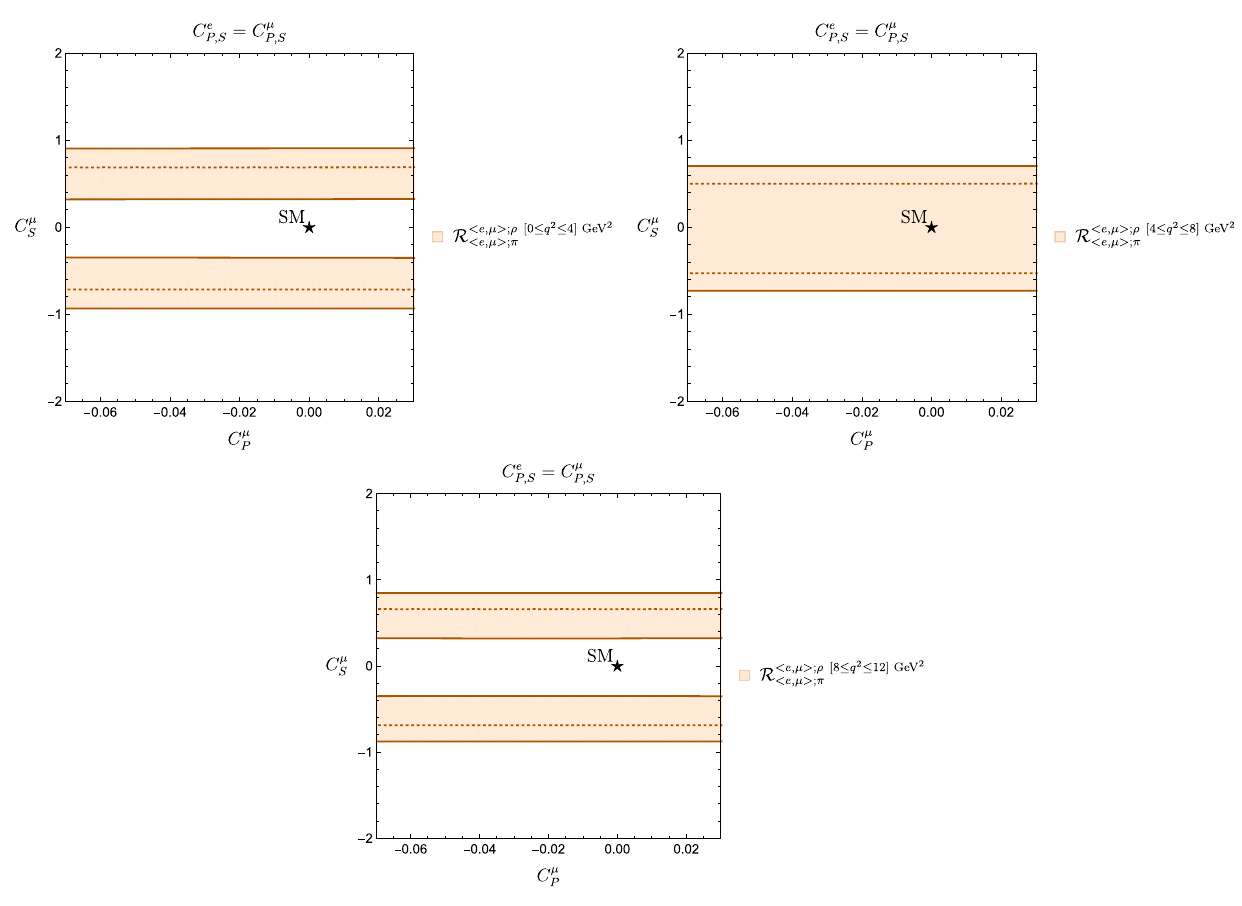
μ μ – C plane for different intervals of q P S